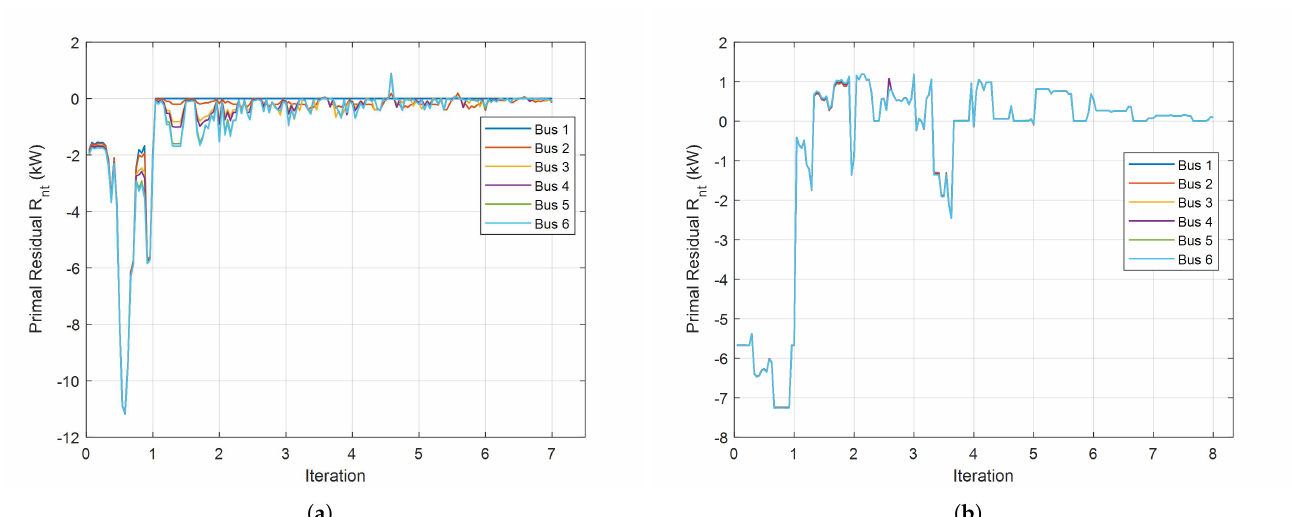
Figure 4. The generation-load mismatches at each bus along iterations. ( a ) Grid-Connected. ( b ) Islanded.